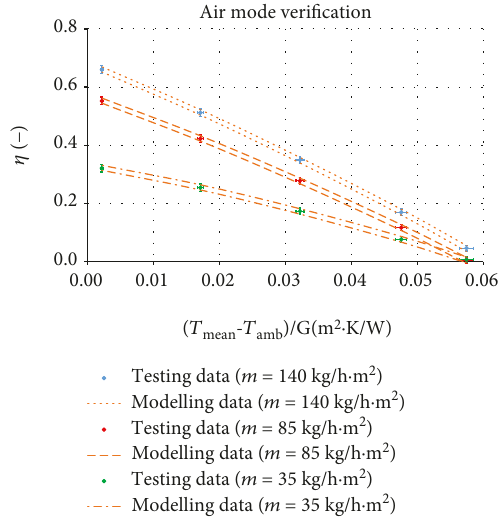
Figure 7: Mathematical model veri fi cation — air heating mode.